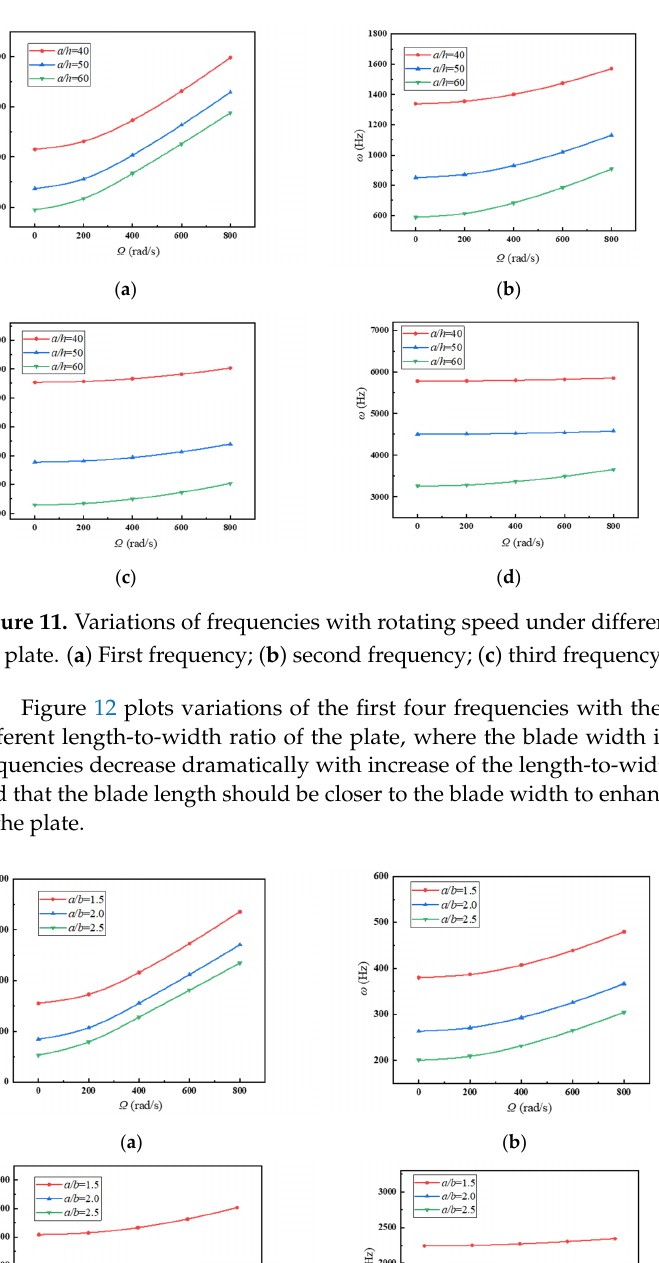
( d ) Figure 13. Variations of frequencies with rotating speed under different pre-twist angles. ( a ) First frequency; ( b ) second frequency; ( c ) third frequency; ( d ) fourth frequency. ( a )